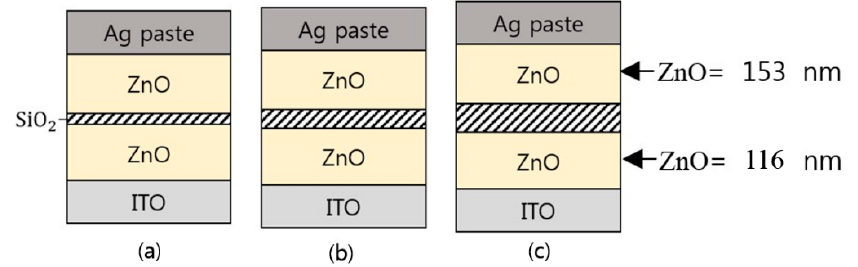
Figure 3. Schematic diagrams of three ZnO/SiO 2 /ZnO micro ‐ energy generators (ZSZ ‐ MGs) with different SiO 2 thin films. ( a ) SiO 2 thickness = 17 nm; ( b ) SiO 2 thickness = 52 nm; ( c ) SiO 2 thickness = 141 nm.